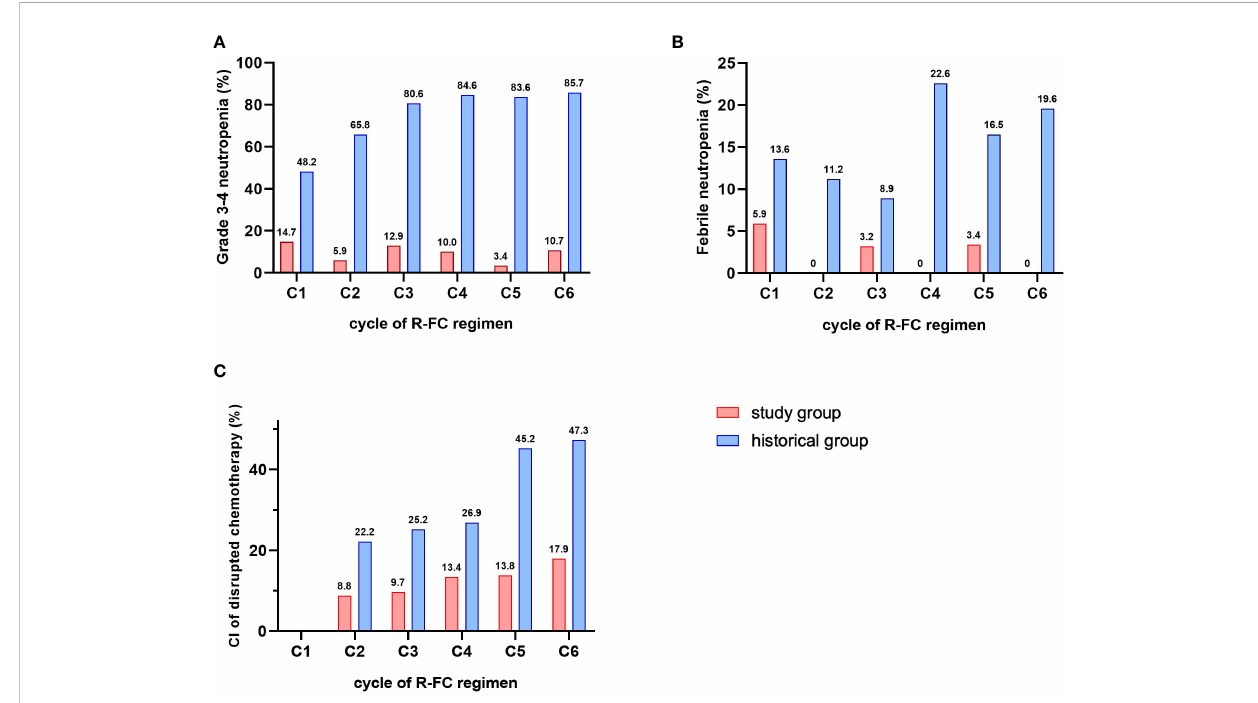
FIGURE 2 Comparison of G-CSF related-factors. (A) incidence of grade 3-4 neutropenia. (B) incidence of febrile neutropenia. (C) cumulative incidence of disrupted chemotherapy.